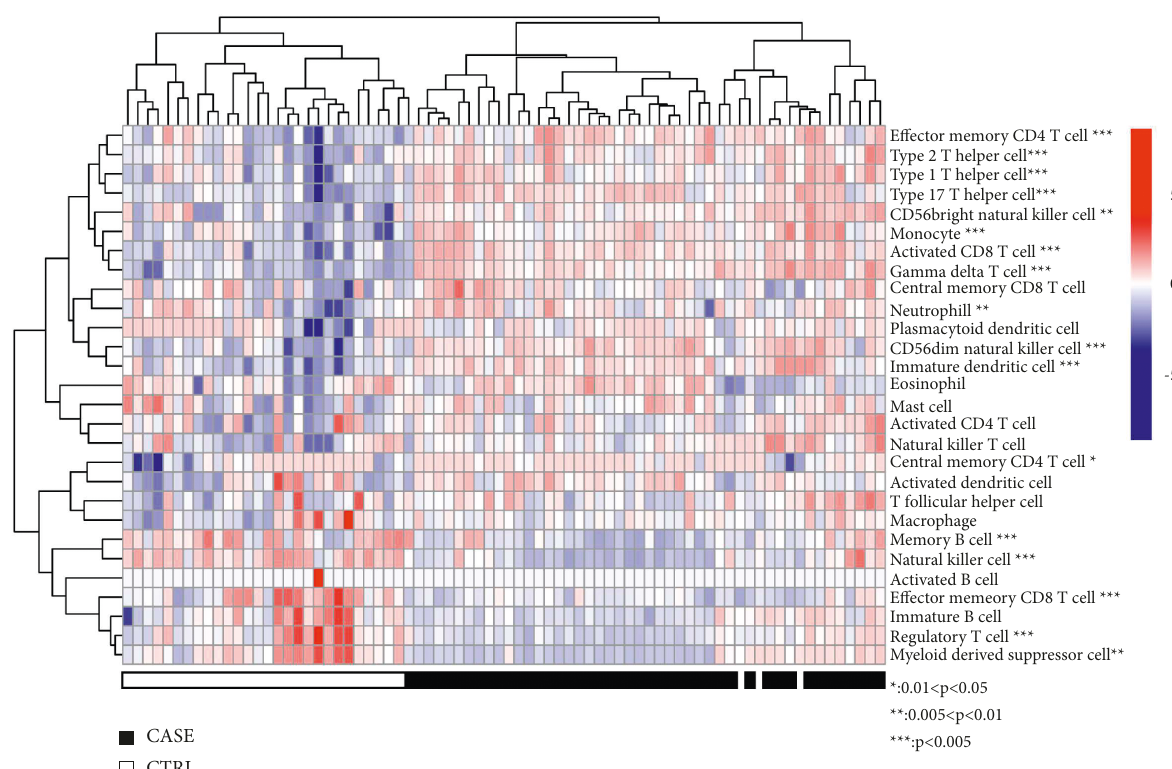
Figure 3: Based on the gene expression profile data detected in the combined samples, the immune fine of each sample is calculated by ssGSEa algorithm. According to the division of cell types, the proportion of 28 immune cell types is obtained. The display diagram is shown in Figure